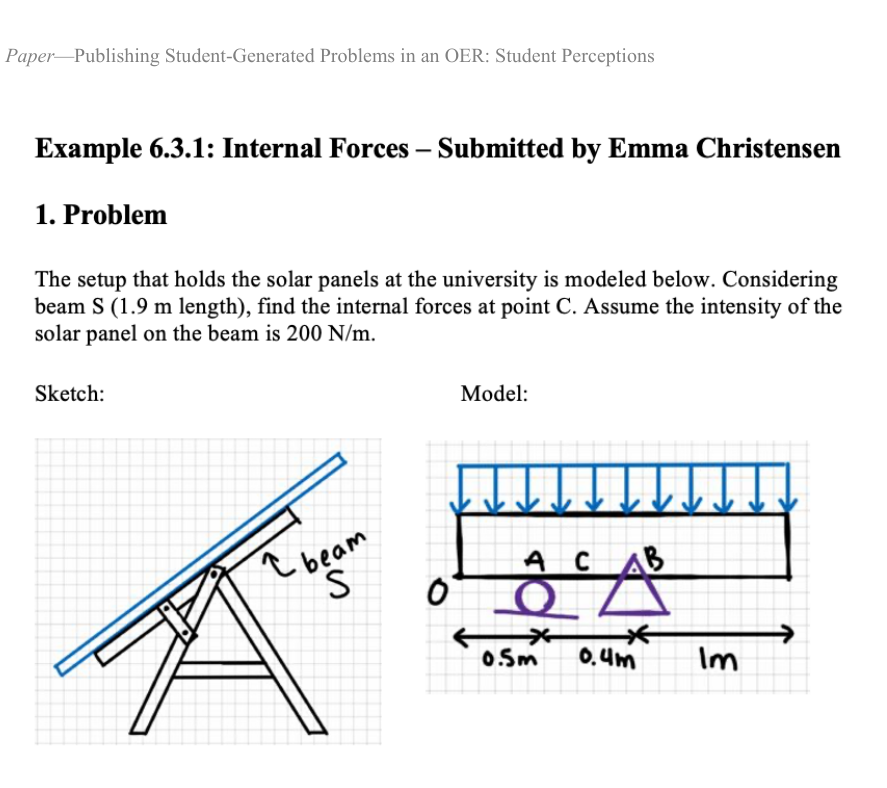
Fig. 1. Sample student-generated problem